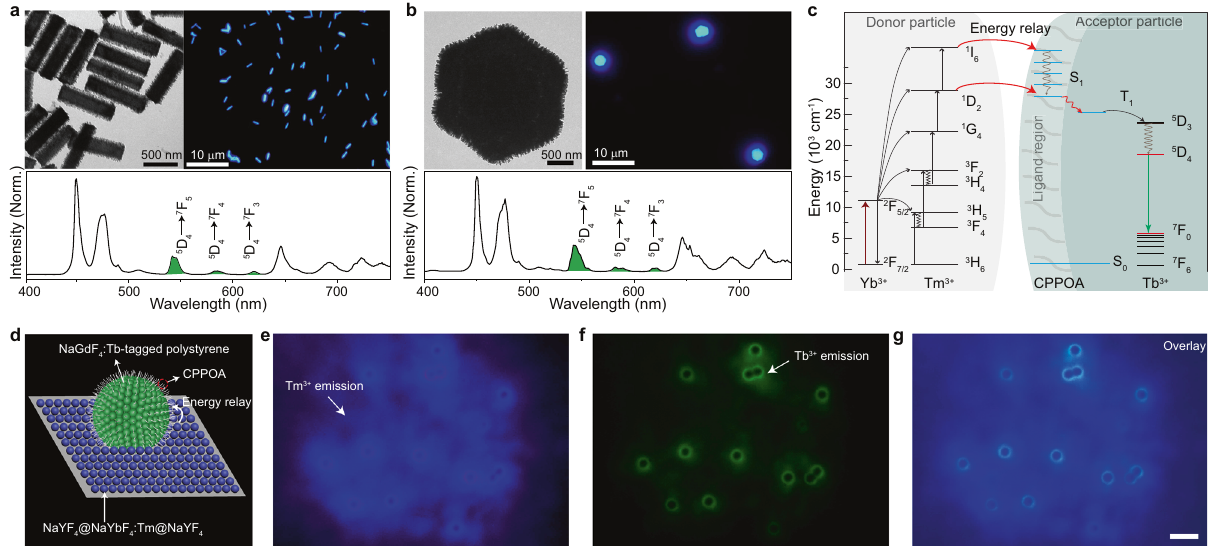
Fig. 4 Long-distance energy relay. a , b Photoluminescence spectra of ( a ) CPPOA-modi fi ed NaYF 4 :Yb/Tm (30/0.5 mol%)@NaGdF 4 :Tb microrods and ( b ) NaYbF 4 :Tm (1 mol%)@NaGdF 4 :Tb microplates under 980-nm excitation. Insets show corresponding transmission electron microscopy images (top left) and upconversion microscopic images (top-right). c The proposed interparticle energy relay between NaYF 4 @NaYbF 4 :Tm@NaYF 4 donor particles and NaGdF 4 :Tb accepter nanoparticles. Excitation energies are fi rst harvested and upconverted in donor nanoparticles, and energy transfer then occurs from Tm 3 + ions in donor nanoparticles to surface ligands (CPPOA) on acceptor nanoparticles. After intersystem crossing in CPPOA molecules, excitation energies are transferred to lanthanide emitters (Tb 3 + ) in acceptor nanoparticles, resulting in upconversion emission. d Schematic illustration of interparticle energy relay. e – g Upconversion microscopy images show interparticle energy relay from NaYF 4 @NaYbF 4 :Tm@NaYF 4 donor particles (blue emission) to polystyrene microspheres tagged with CPPOA-modi fi ed NaGdF 4 :Tb nanoparticles (green emission) using a ( e ) 500-nm shortpass fi lter or ( f ) 540 ± 25 nm bandpass fi lter. Scale bar: 10 μ